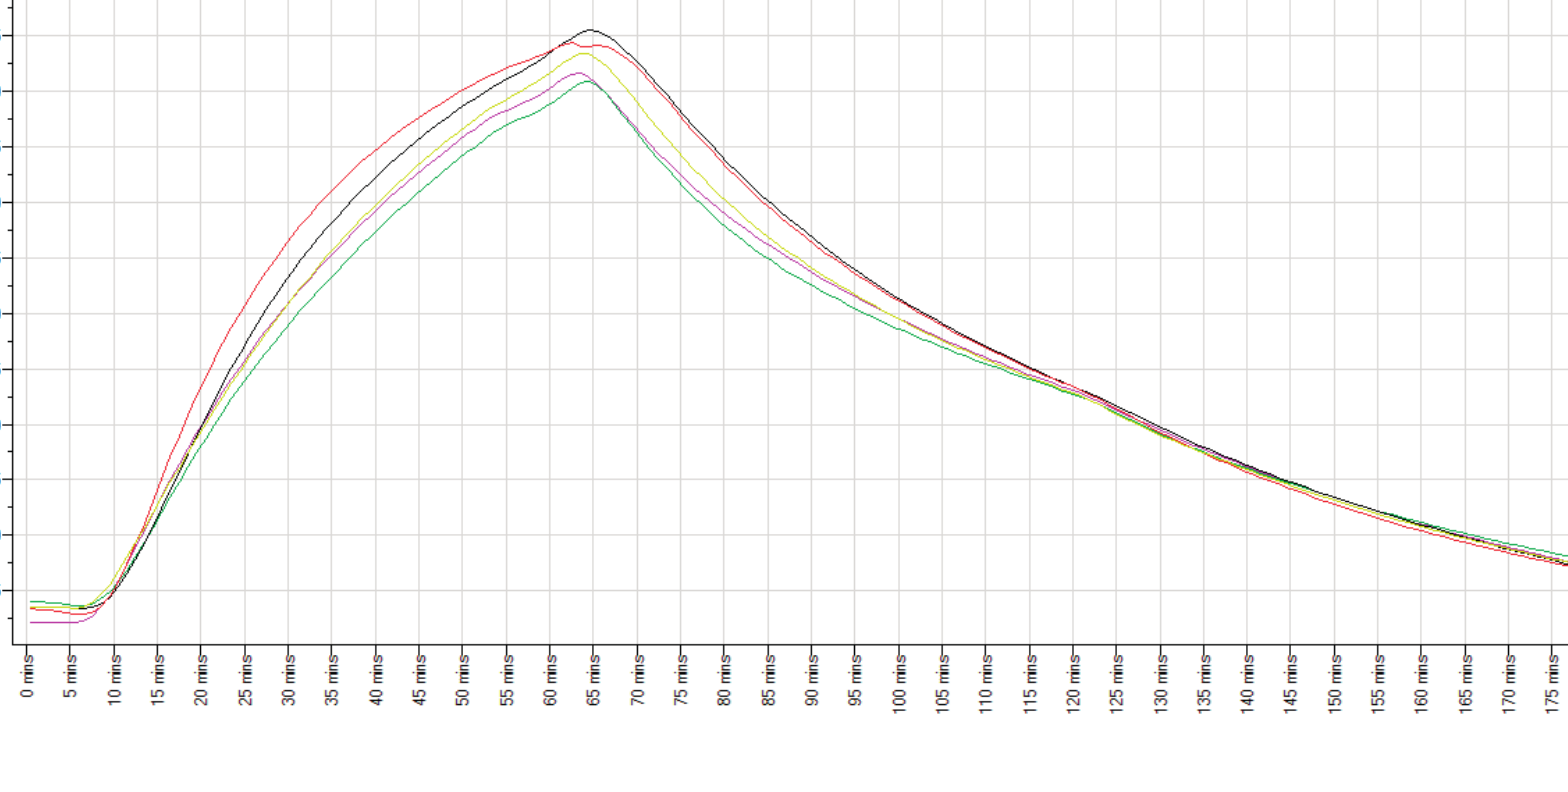
Figure 2. Typical temperatures achieved at the corners (yellow, black, red and green) and center (pink) of a terrine of macerated chicken livers during baking in a Bain Marie and during cooling after removal from the